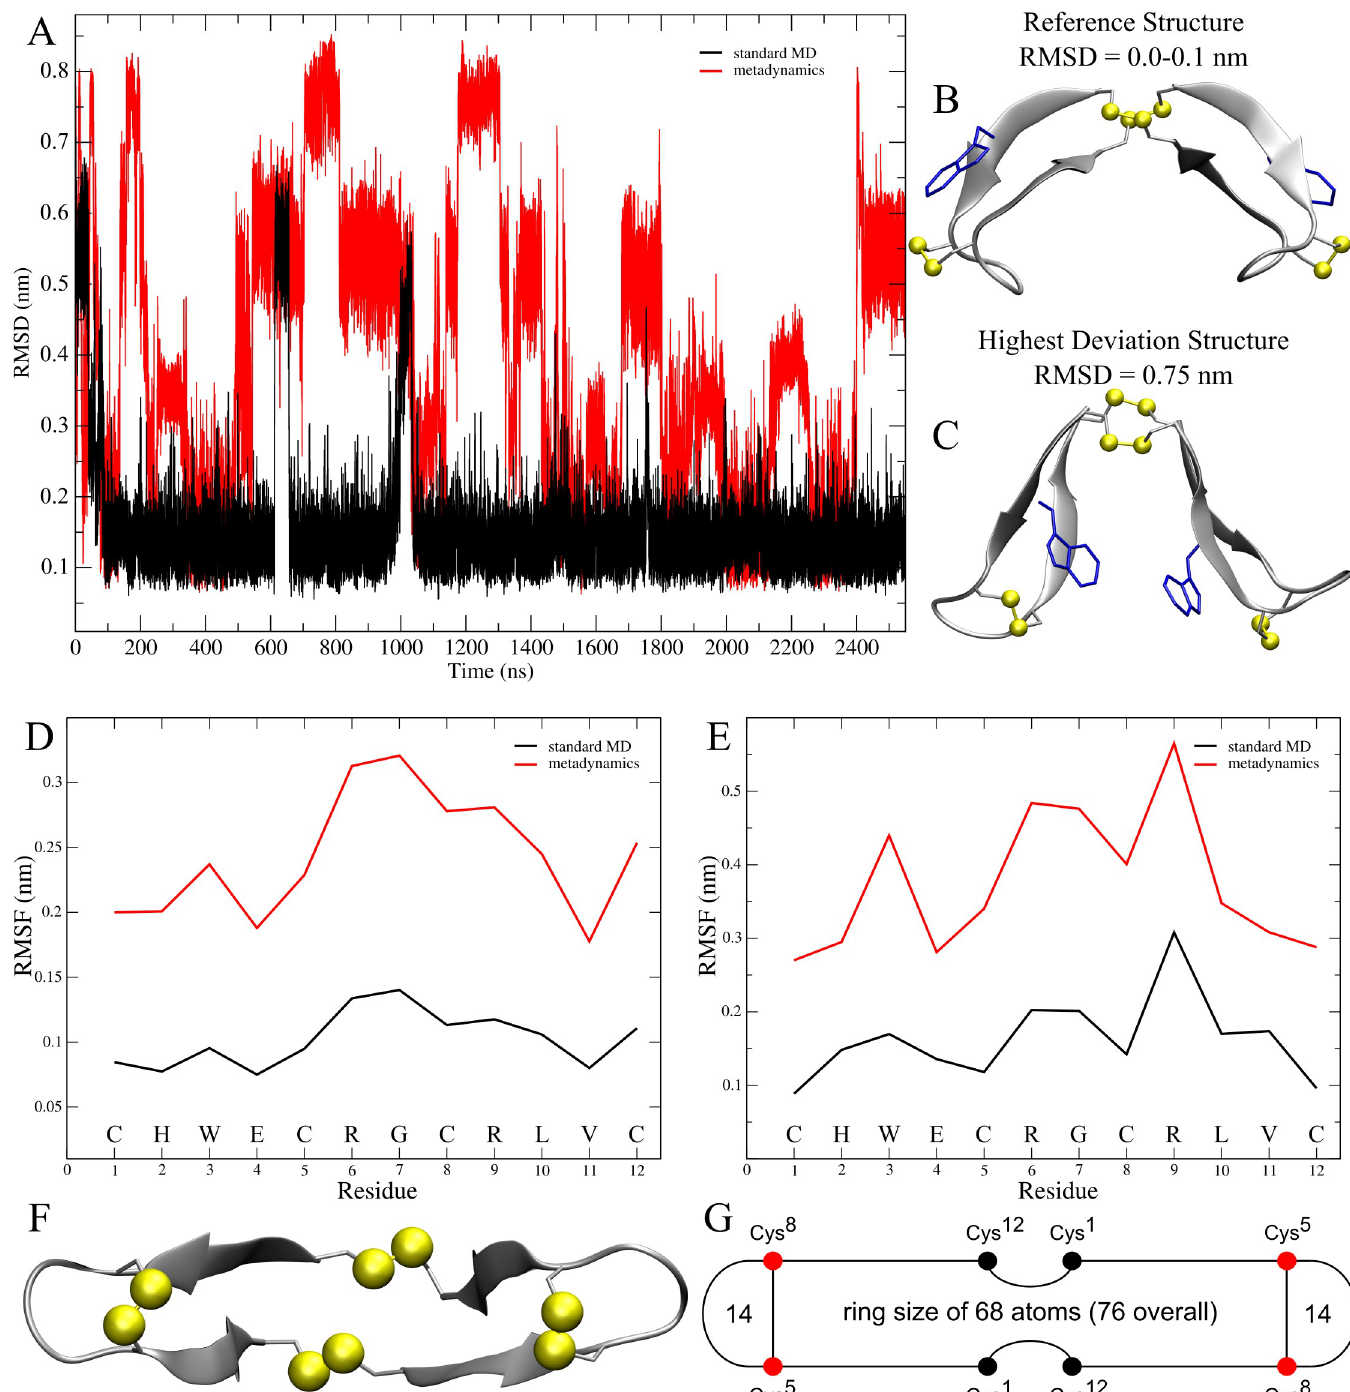
Fig 2. Root-mean-squared Deviation (RMSD) and root-mean-square fluctuation (RMSF) analysis of the hinge peptide with representation of important structural features. The RMSD value development during the classical (MD) simulation (black) and metadynamics (red) (A). On the right, structural representation of the reference structure (B) and highest deviation structure in comparison to the reference (C) during the MD simulation with their respective RMSD value. The RMSF of the backbone atoms (D) and side chain residues (E) are depicted. Bottom view of the hinge peptide backbone with cysteine as bridgehead atoms (F) next to the simplification of these structural features